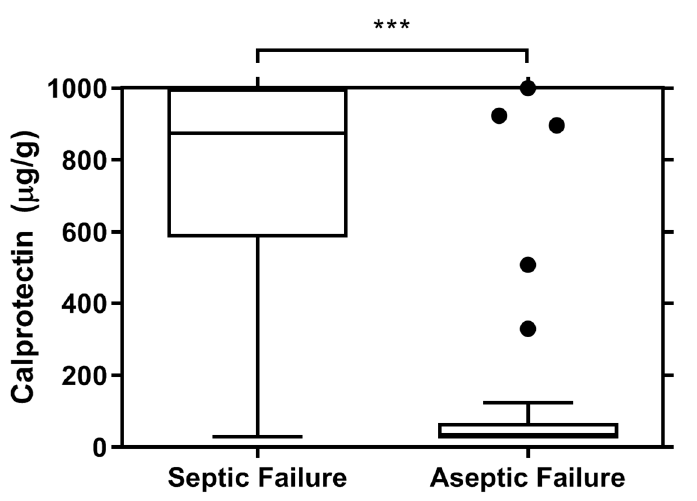
Figure 1. Calprotectin levels distribution among septic and aseptic cases. Statistical significance: *** p < 0.001.